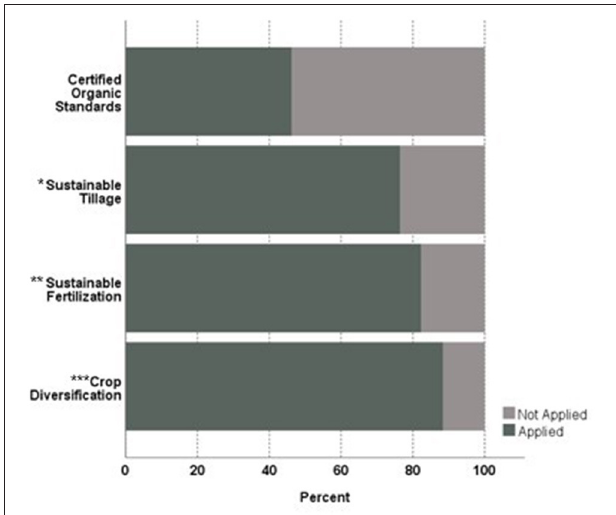
FIGURE 1 | Frequency of compliance with organic standards and use of specific agroecosystem management practices of surveyed producers (% of responses, n = 53). *Conservation Tillage or Direct Seeding. **Use of compost, compost tea, charcoal, and/or manure. ***Crop rotations, intercropping and/or cover cropping.